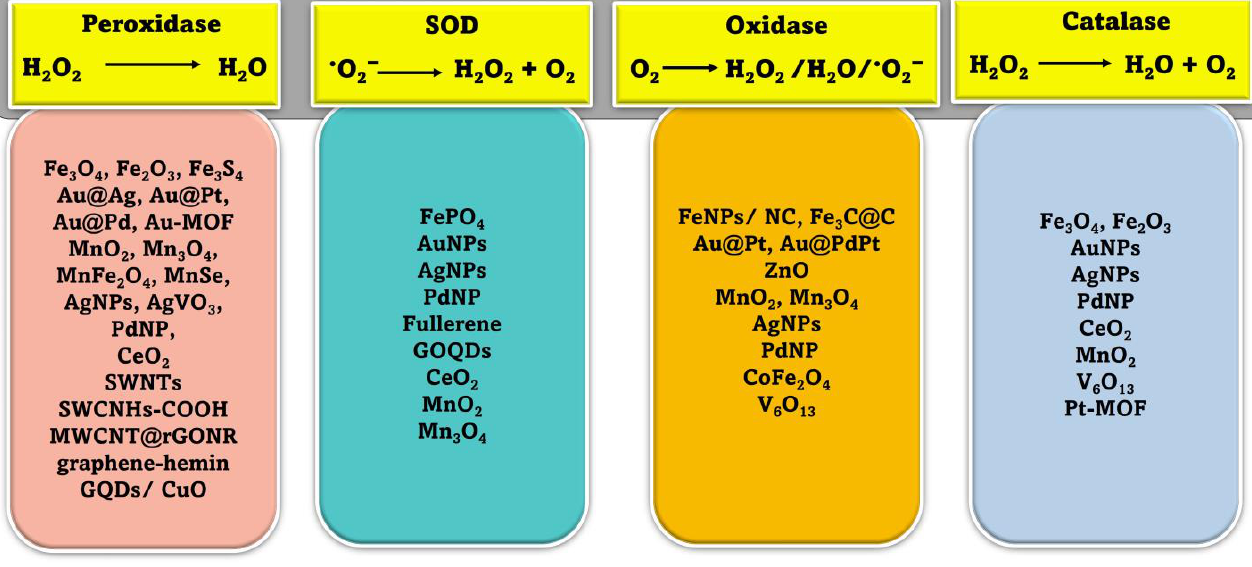
Figure 2. Schematic representation of different enzyme-mimicking actions of nanozymes with examples